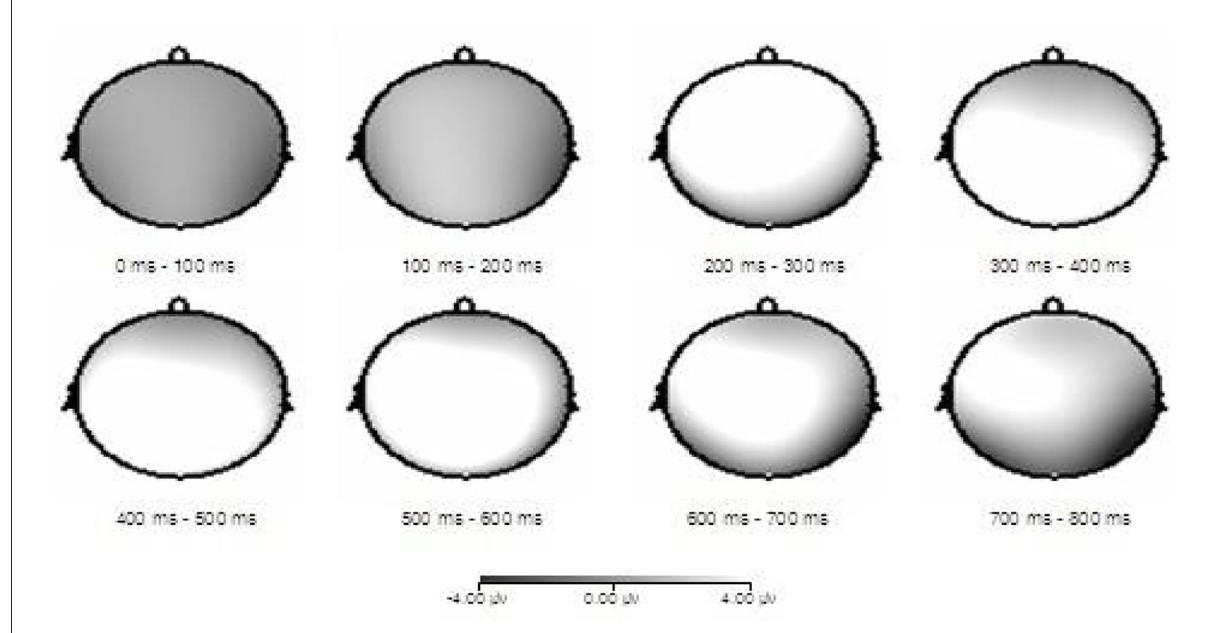
FIGURE3 ERP differential waveform topographic maps of the DD and TD groups under the negative priming